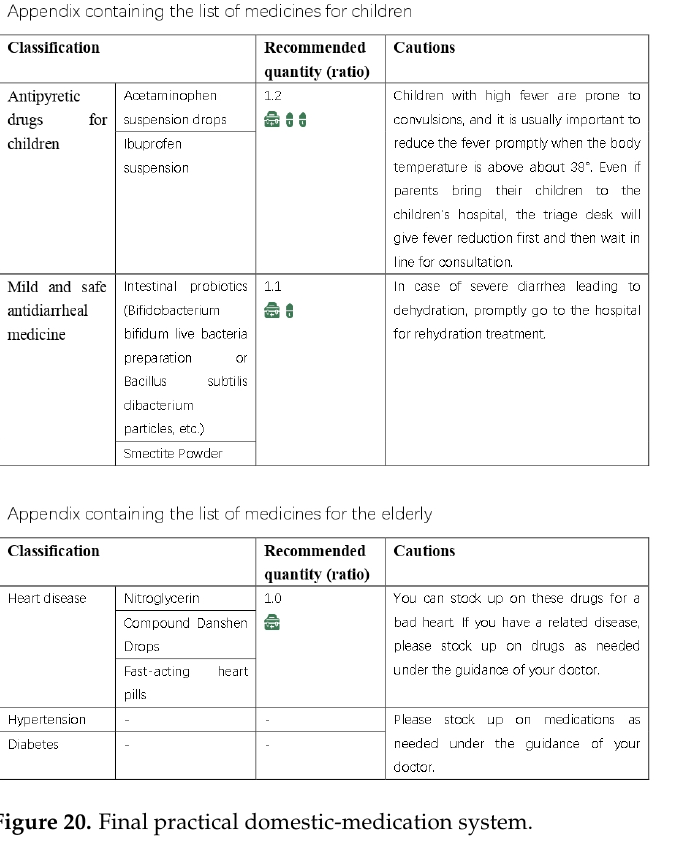
Figure 19. Final practical domestic-medication system.